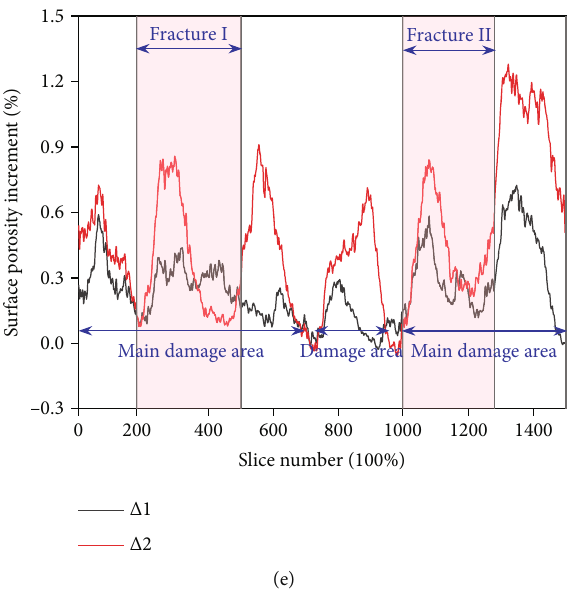
Figure 7: Variation curve of incremental value of surface porosity of rock samples with di ff erent saturations.